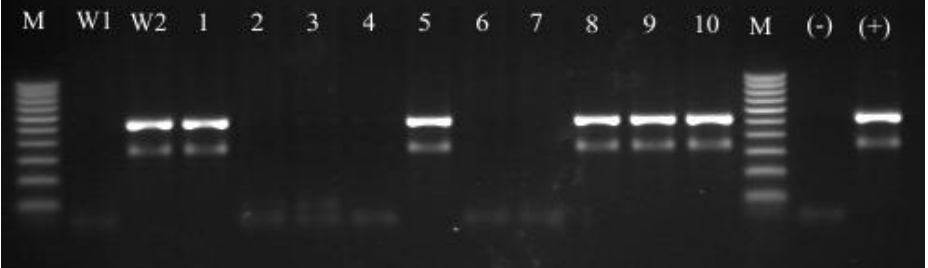
Figure 2. Identification of mecA gene fragment (533 bp). W1— S. aureus MSSA ATCC 25923; W2— S. aureus MRSA ATCC 43300; 1–10 S. aureus clinical isolates; M-100–1000 bp marker, (+) positive control, (−) negative